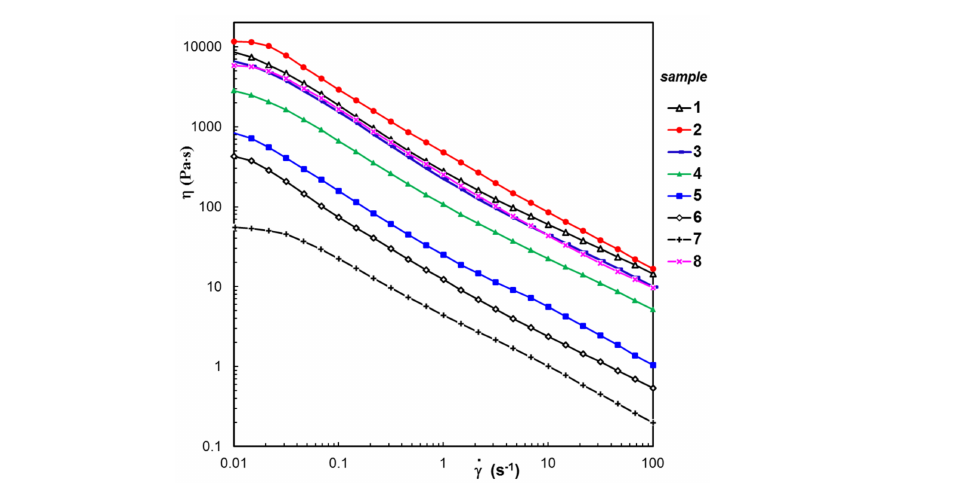
Figure 6. The variation of shear viscosity ( η ) with the applied shear rate ( in steady shear conditions (37 ◦ C).